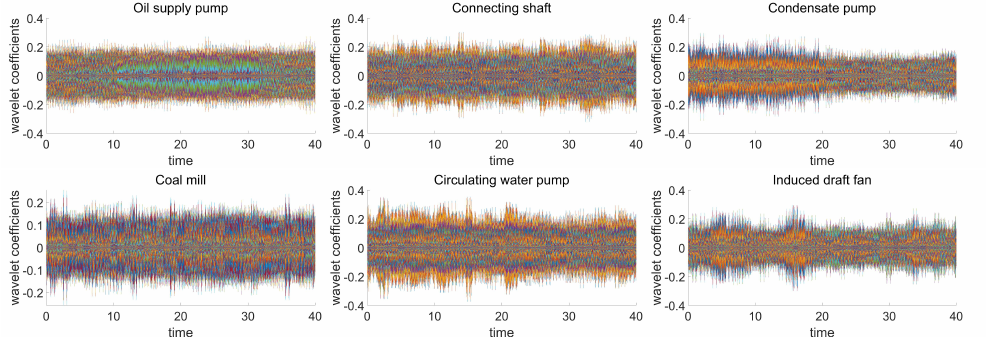
Figure 2. Sample image. The abscissa represents time and the ordinate represents wavelet coefficients.